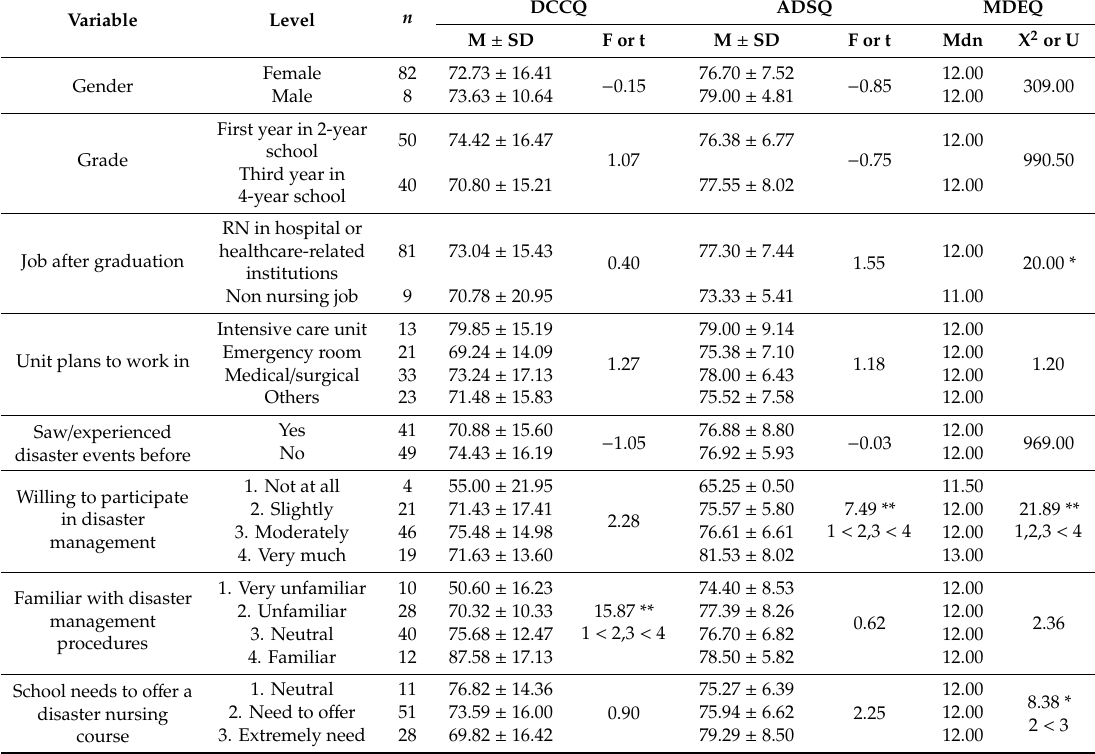
Table 2. Di ff erences on the disaster nursing competence, anticipatory disaster stress, and motivation for disaster engagement by demographic